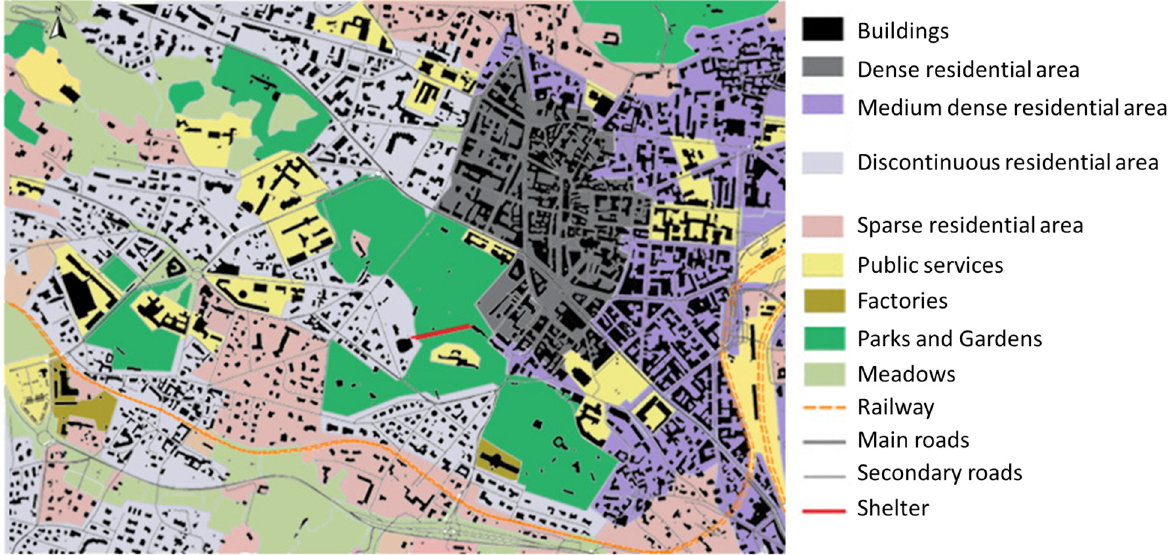
Figure 6. Visualization of land use of the area where the air-raid shelter is located. Elaboration by A. A. Pilo.